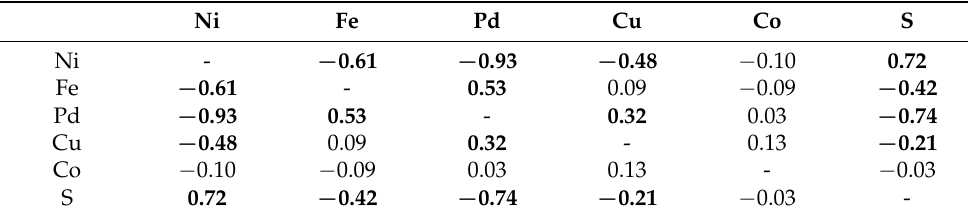
Table 6. Spearman’s rank correlation coefficients of Pd-rich pentlandite components in wt.% calcu- lated from the data set containing 277 analyses.